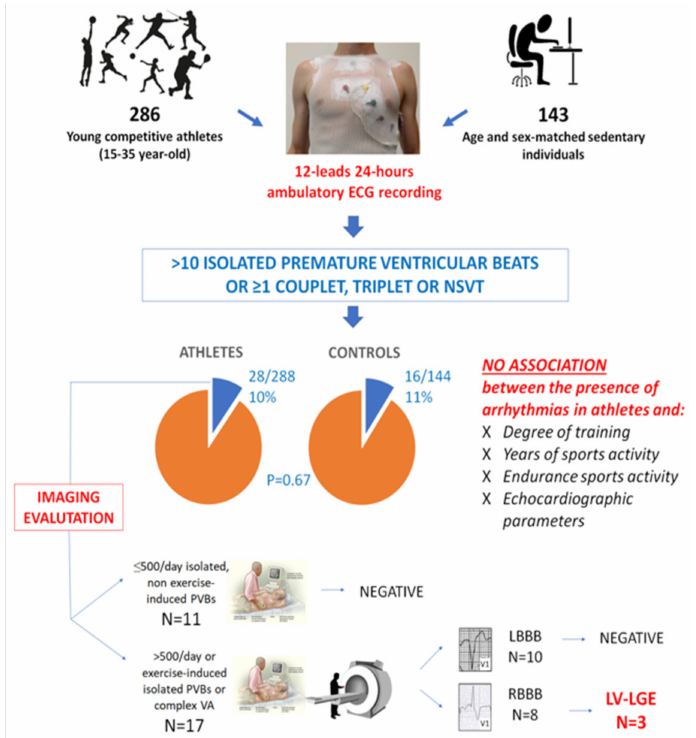
Figure 4. Summary of the main findings of a study enrolling 286 young competitive athletes and 143 healthy sedentary controls who volunteered to undergo 12-lead 24 h ambulatory ECG monitoring. LBBB, left bundle branch block; LGE, late gadolinium enhancement; LV, left ventricular; NSVT, non- sustained ventricular tachycardia; PVB, premature ventricular beat; RBBB, right bundle branch block; VA, ventricular arrhythmia. Reproduced with permission from